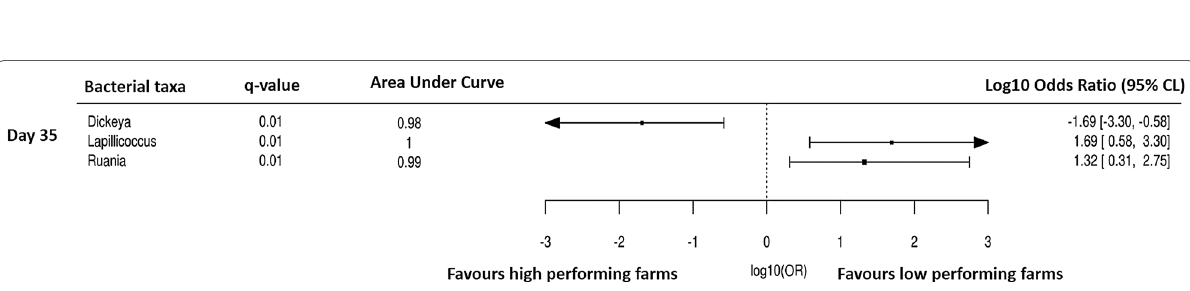
90. The results to the ≥